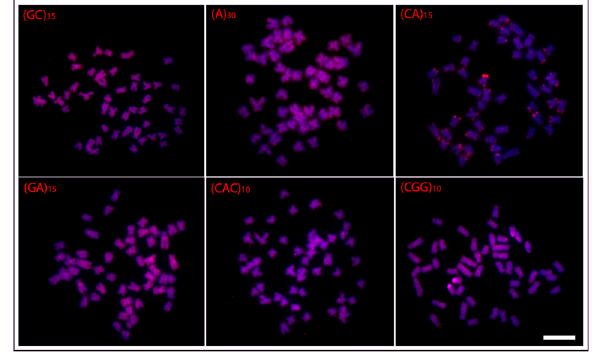
Figure 6 – Hybridization patterns with microsatellites probes (red signals) on metaphase plates of the Osteochilus vittatus . Chromosomes were counterstained with DAPI (blue). Scale bar = 5 μm.